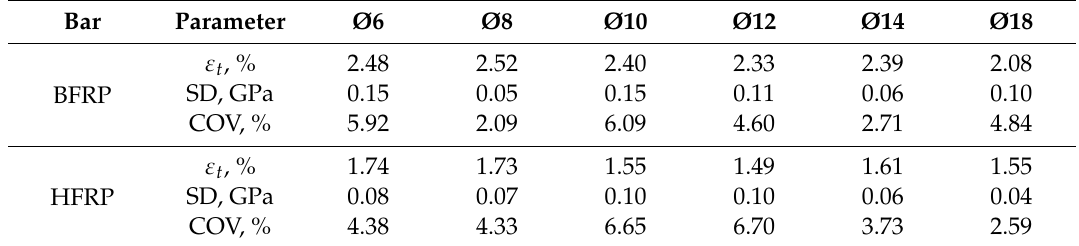
Table 4. Strains at FRP bars